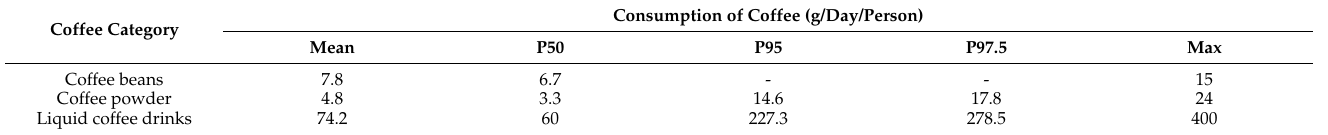
Table 2. Statistical summary of coffee consumption data among Chinese